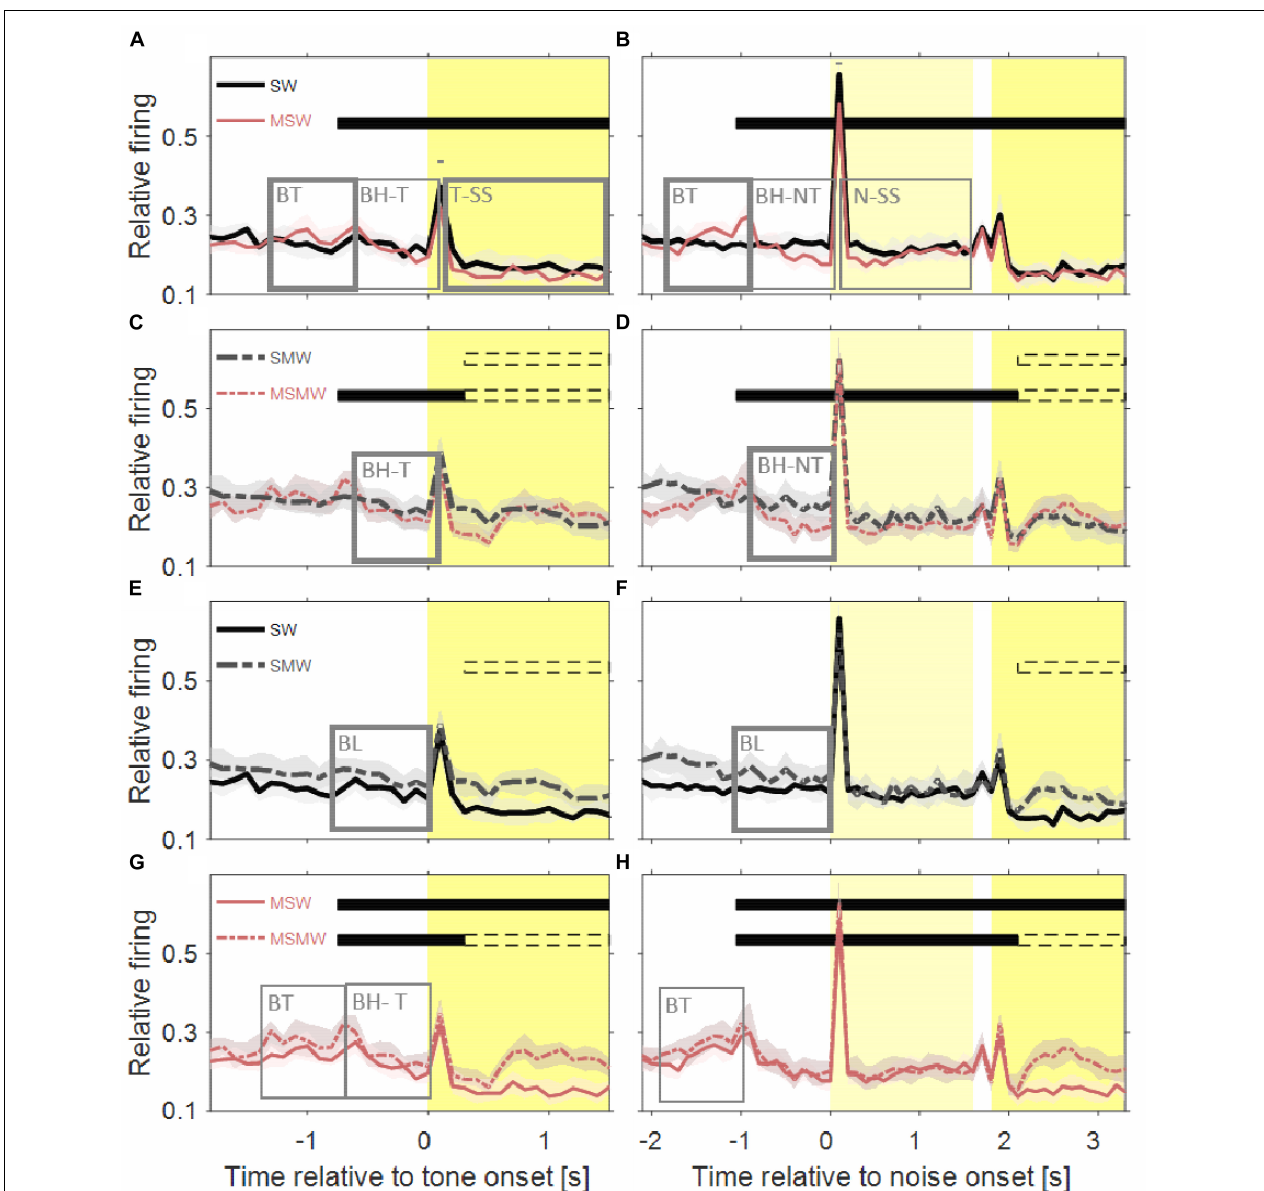
FIGURE 4 | Comparisons of population firing rates between pairs of conditions of the task block. The time is relative to the first sound in a trial. (A,B) SW versus MSW, (C,D) SMW versus MSMW, (E,F) SW versus SMW, (G,H) MSW versus MSMW. Other conventions as in Figures 1 , 3 . The dashed rectangles indicate the time interval in which the monkeys had to exhibit a motor response to the tone. The solid rectangles and the short bars denote time intervals in which there was a significant difference in firing rates between the two conditions shown in a panel, with thin lines indicating p < 0.01 and thick lines indicating p <